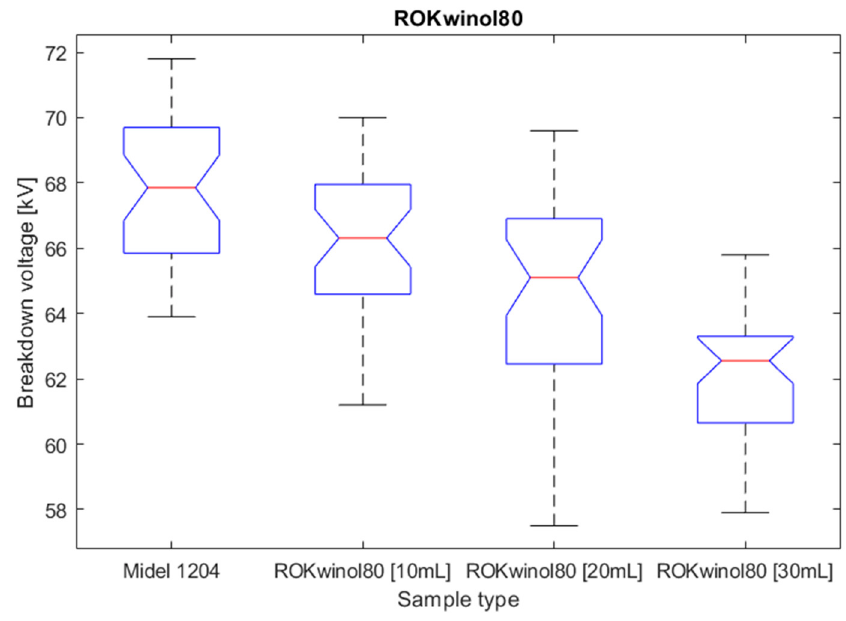
Figure 13. Box plot for surfactant population of ROKwinol80 .